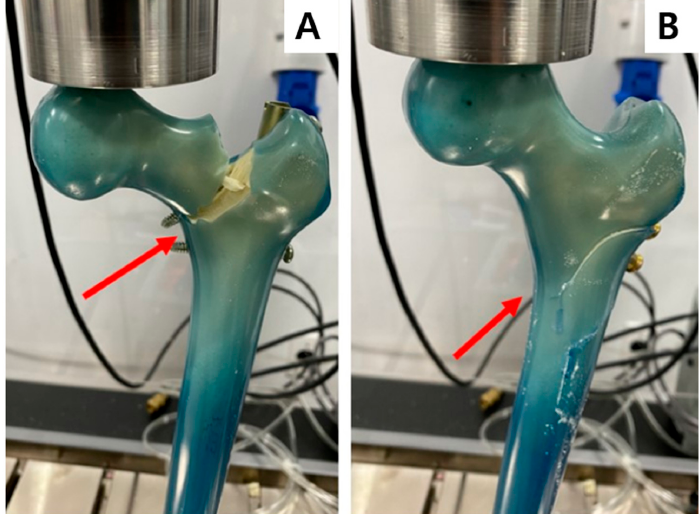
Figure 3. Failure modes after axial compressive loads. All constructs of group SN showed a basicer- vical femoral neck fracture from the GT nail entry hole through the proximal oblique interlocking screw ( A ). In the RN group reconstruction nail, five constructs exhibited a subtrochanteric fracture through the reconstruction screw hole, but without a femoral neck fracture ( B ). GT, greater trochanter. Red arrows point to the fracture lines.